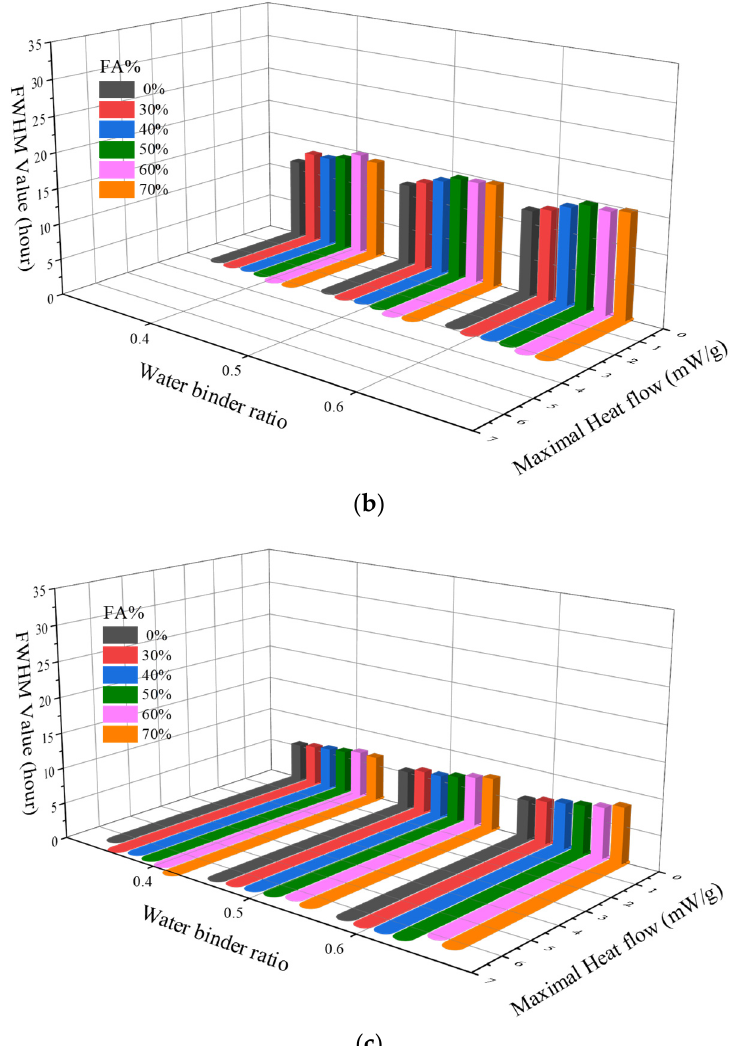
Figure 11. FWHM and exothermic peak values at different temperatures (normalized to cement). ( a ) FWHM and exothermic peak values at 10 °C; ( b ) FWHM and exothermic peak values at 20 °C; ( c ) FWHM and exothermic peak values at 35 °C.